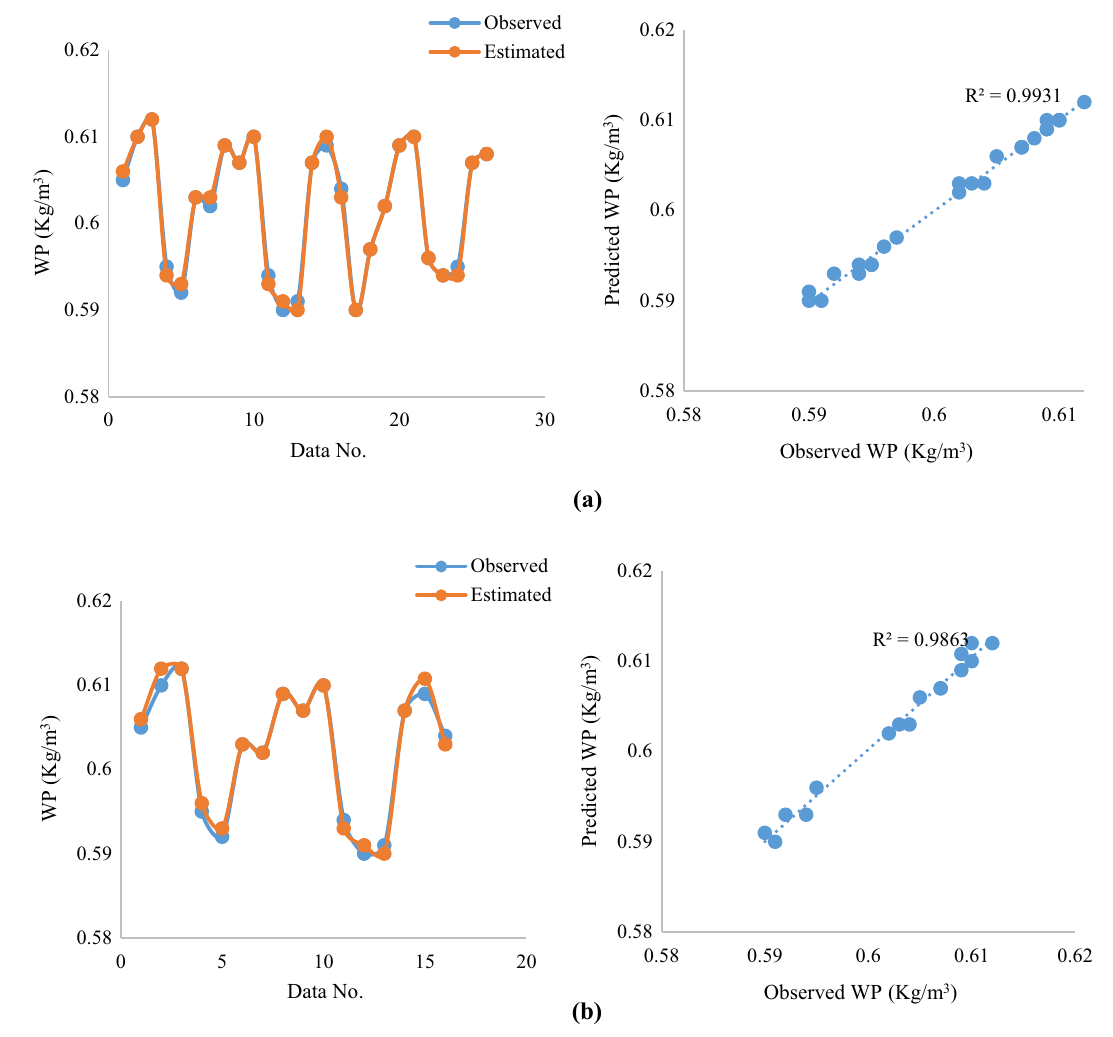
Fig. 8 a , b Comparison of predicted WP with observed values a ACVO-ANFIS on the training dataset b ACVO-ANFIS on test